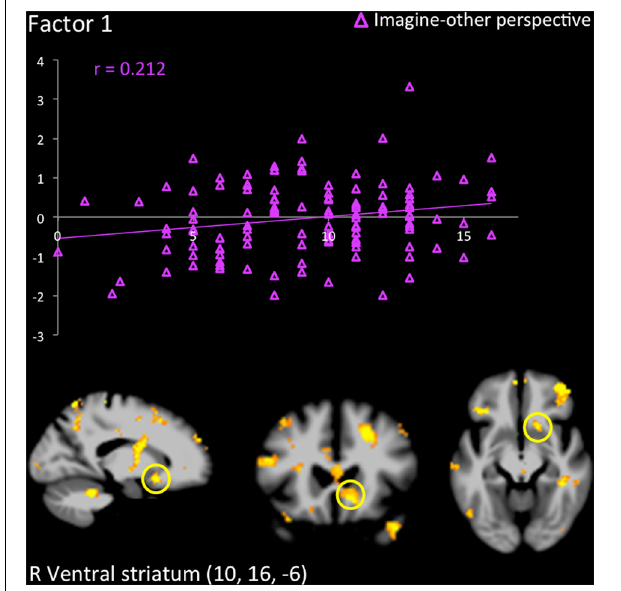
FIGURE 1 | Response in the right amygdala across groups of low (L), medium (M), and high (H) psychopathy (on total PCL-R scores) participants, when they adopted an imagine-self and an imagine-other affective perspective while viewing bodily injuries. Groupwise effects (bars at the bottom of the figure) are expanded to show the contribution of continuous PCL-R subscores on Factor 1, which encompasses the emotional/interpersonal features of psychopathy.